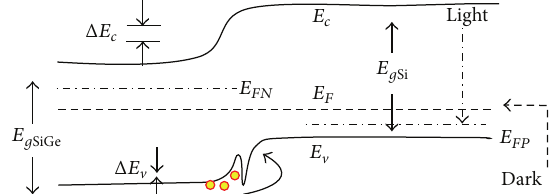
Figure 4: Band diagram of p-n junction solar cell in darkness and under